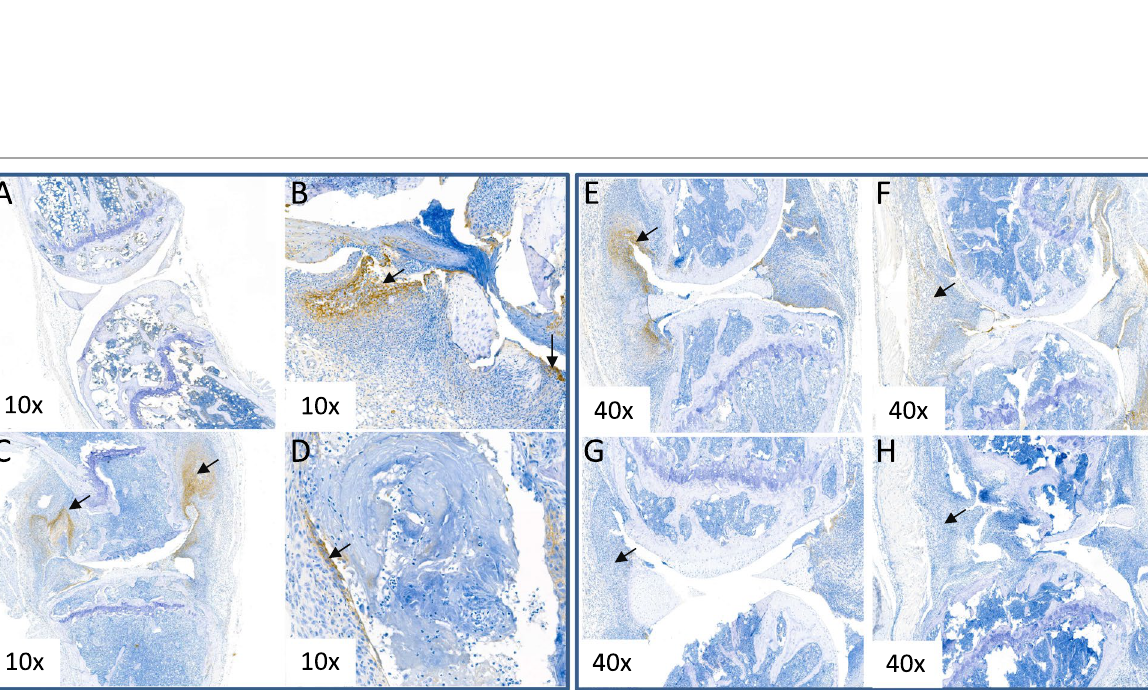
Fig. 3 Duration and dose-down of anti-FnEDA biodistribution in mCIA joint tissue. Dosed anti-FnEDA mAb detected by IHC in joints of naïve animal ( A ) and mCIA animal after 48 h ( B ), 6 days ( C ) and 13 days ( D ). For dose-down study, i.v. injection was administered to mCIA animals at: 3 mg/kg ( E ), 1 mg/kg ( F ), 0.3 mg/kg ( G ) and 0.1 mg/kg ( H ). (N 3, Arrows point to disease specific structures, magnification level is noted in each =